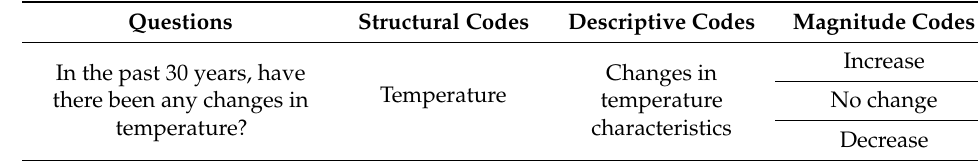
Table 1. Coding variables used for analysing interview